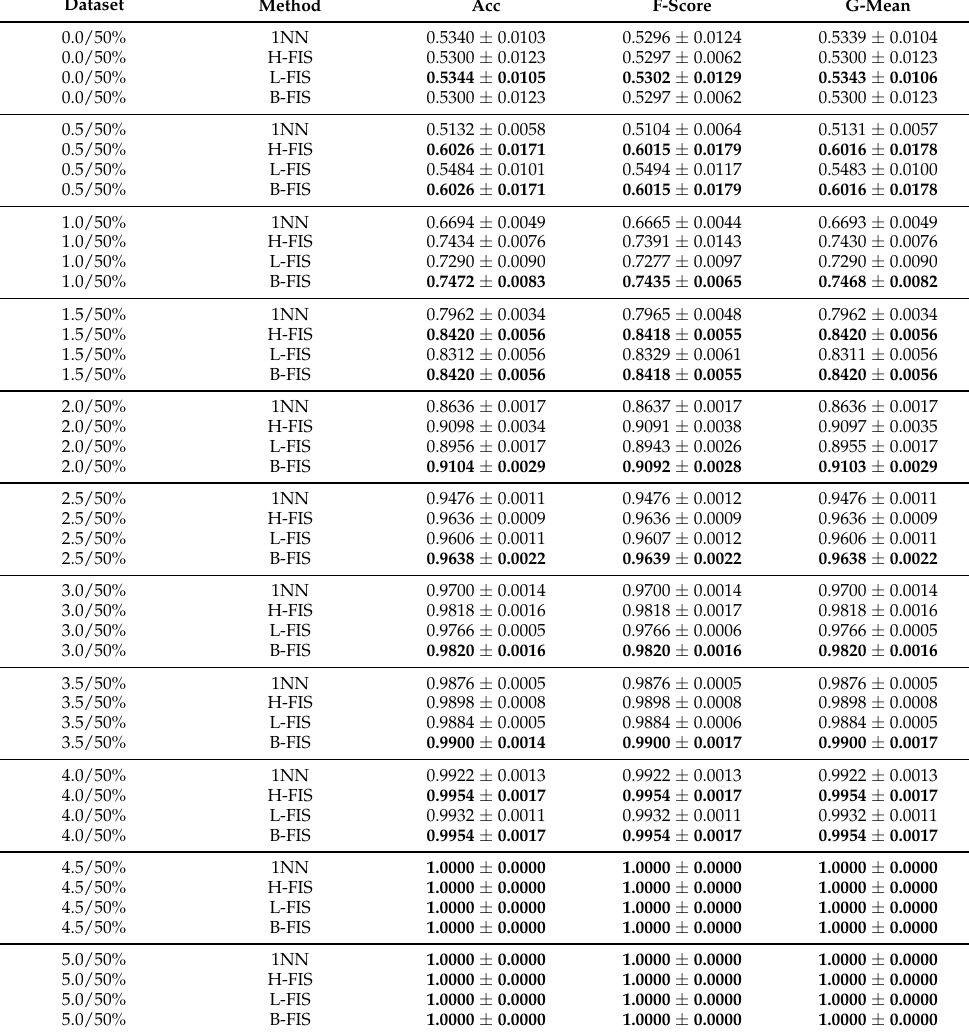
Table 4. Results for artificial dataset with 50% of positive